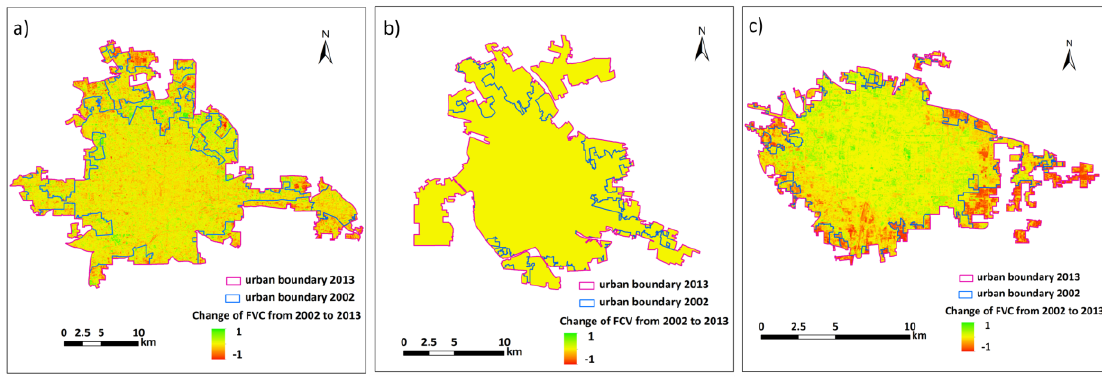
Figure 12. Change pattern of FVC from 2002 to 2013 in ( a ) Beijing, ( b ) Tianjin and ( c ) Shijiazhuang.